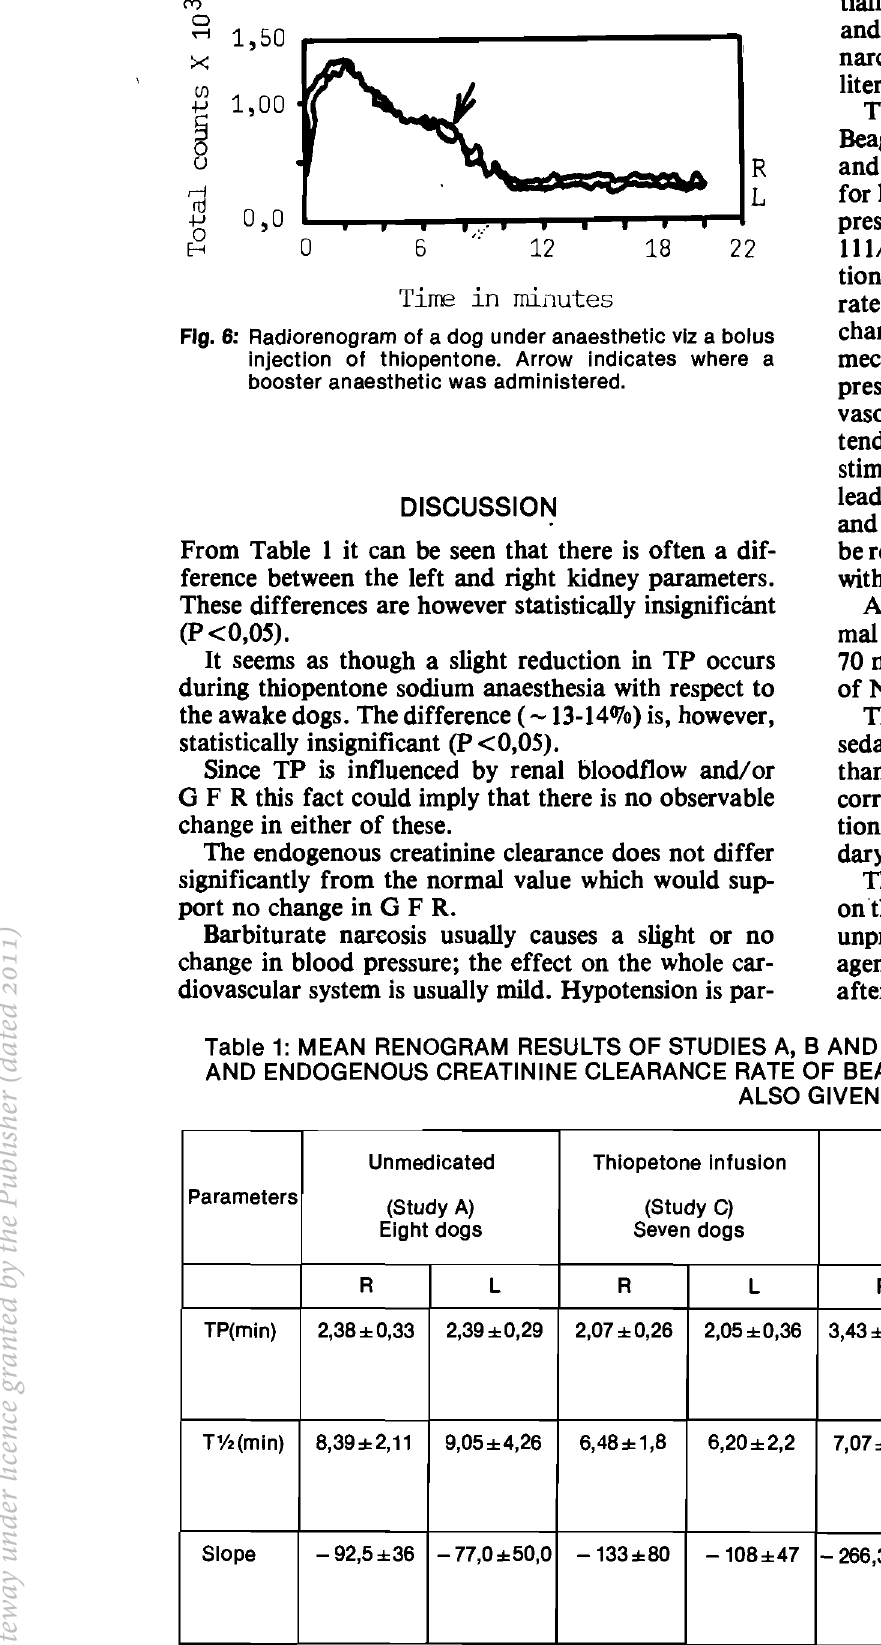
Fig. 6: Radiorenogram of a dog under anaesthetic viz a bolus injection of thiopentone. Arrow indicates where a booster anaesthetic was administered.